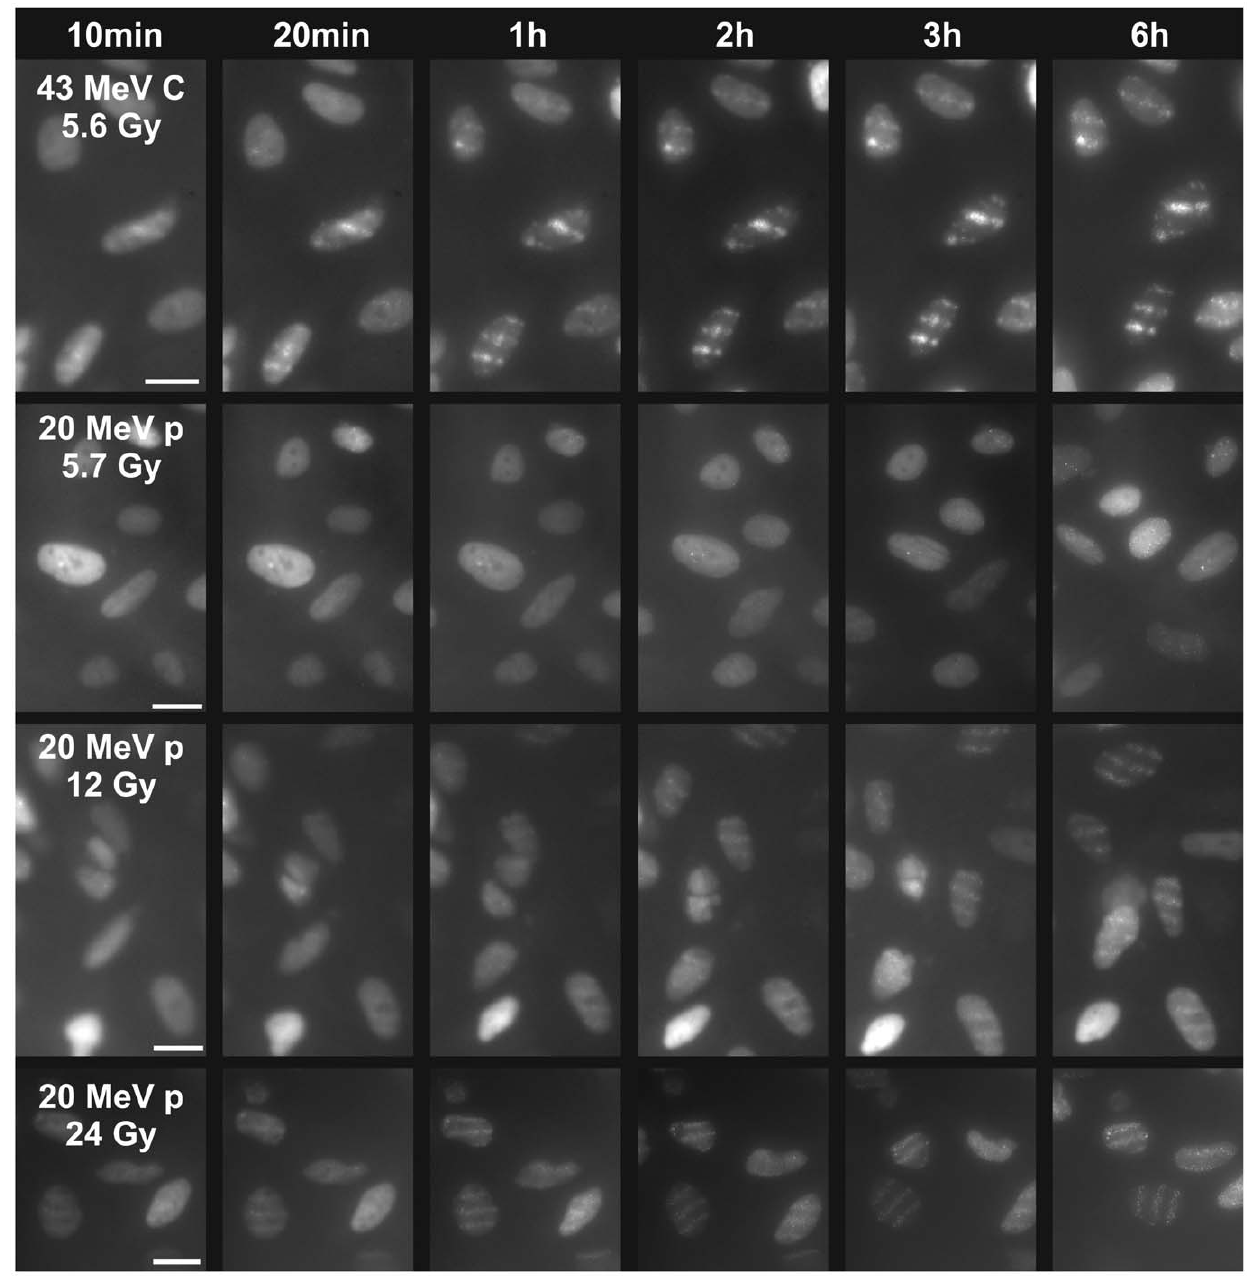
Figure 4. Dose and LET dependent kinetics of Rad52. 10–20 min after irradiation with 43 MeV carbon ions (5.6 Gy, one ion per point) foci become visible. When applying the similar dose by 117 20 MeV protons per point first very weakly developed foci become visible not before three hours have elapsed (upper right nucleus). Increasing the number of protons per point accelerates the kinetics; with 512 protons per point (i.e. 24 Gy) already ten minutes after irradiation foci can be seen, so that kinetics is similar to that of 5.6 Gy carbon irradiation. Scale bars 20 m